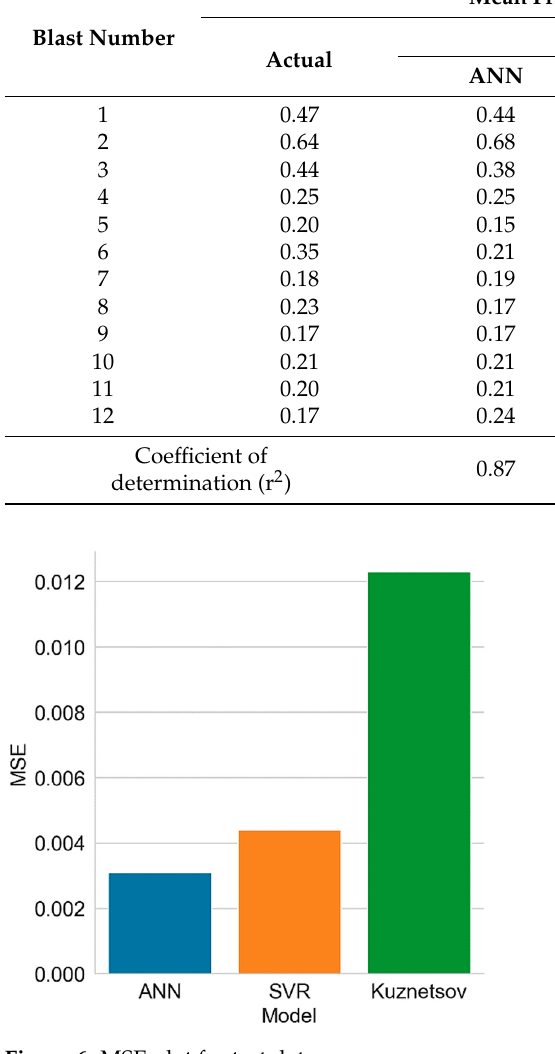
Figure 6. MSE plot for test